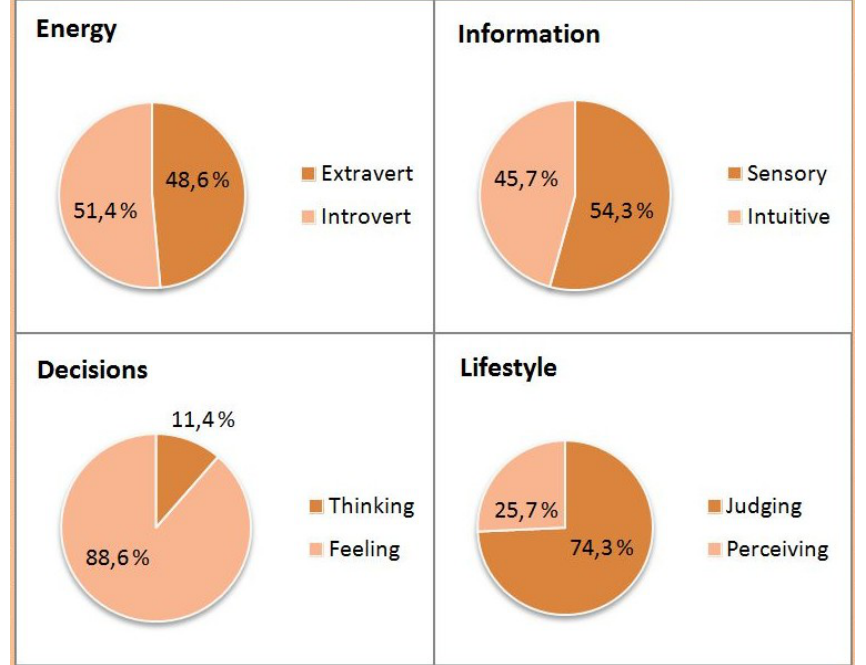
Figure 1. Distribution by dichotomies (total: